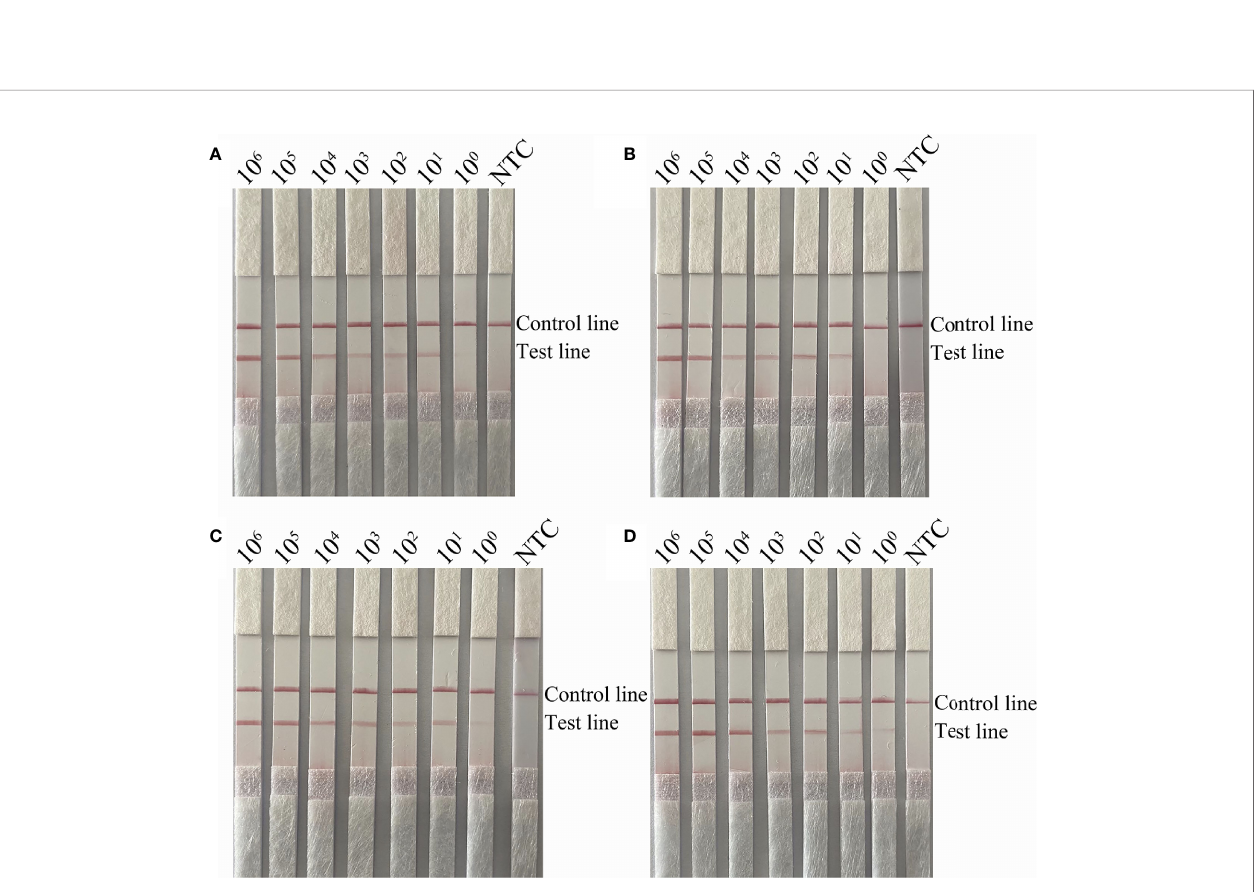
FIGURE 4 | Detection limit of the RPA-LFS system. (A, B) LFS results of RPA ampli fi cations with different amounts of non-capsulated H. in fl uenzae . The amounts (in CFU) added to the RPA reactions are indicated at the top of each strip. In (B) , 10 5 CFU/ m L of S. pneumoniae were added to the reactions in addition to the non- capsulated H. in fl uenzae culture. (C, D) LFS results of RPA ampli fi cations with different amounts of capsulated H. in fl uenzae . The amounts added to the RPA reactions are indicated at the top of each strip. In (D) , 10 5 CFU/ m L of the culture of S. pneumoniae was added to the reactions in addition to the capsulated H. in fl uenzae . NTC, no template control. The reactions were performed for 30 min at 37°C. The positions of the control and test lines are indicated on the right of the